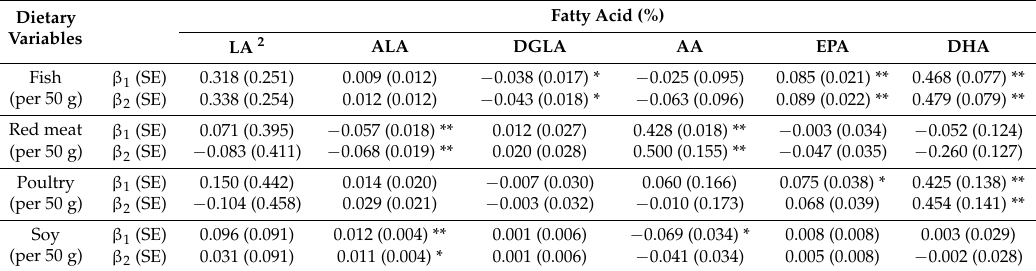
1 β (SE) are regression coefficients (standard errors) from linear regression analysis. Values for the β coefficients represent the percentage change in plasma fatty acid composition for every 50 g per day increment in fish, red meat, poultry and soy consumption. β 1 : model adjusted for sex and age; β 2 : model additionally adjusted for body mass index, physical activity, total energy intake, alcohol consumption, and other meats or meat alternatives (fish, red meat, poultry, and soy). * p -value < 0.05; ** p -value < 0.01. 2 Fatty acid abbreviations: LA (linoleic acid; 18:2 n -6), ALA (alpha-linolenic acid; 18:3 n -3), DGLA (dihomo-gamma-linolenic acid; 20:3 n -6), AA (arachidonic acid; 20:4 n